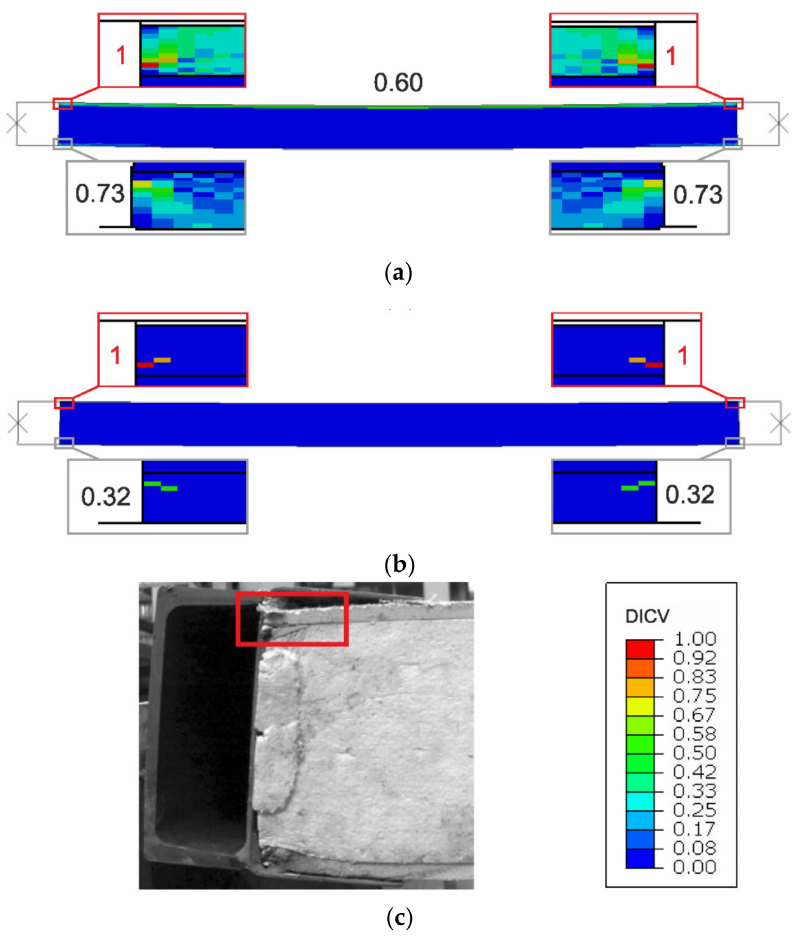
Figure 14. Comparison of failure modes in natural-scale e0 panel compression test; FEA results: